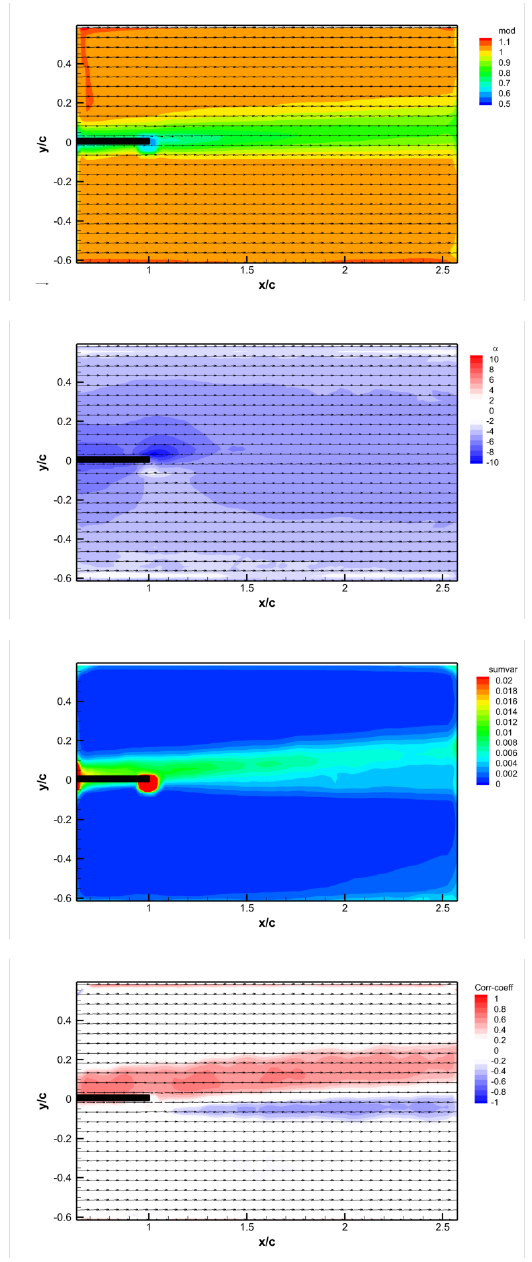
Fig. 4. Mean velocity, down wash angle, TKE and correlation coefficient distributions, the wake .